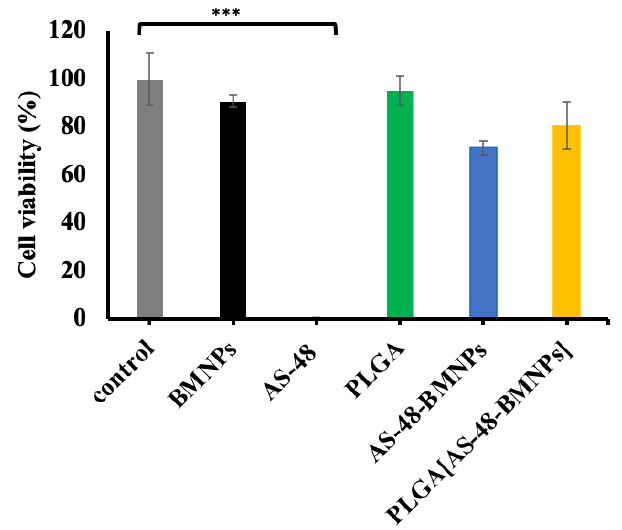
Figure 8. Viability assay in TH1-P cell line following treatment with culture medium (control), BMNPs (229 μg/mL), AS-48 (32 μg/mL), PLGA (457 μg/mL), AS-48-BMNPs (229 μg/mL BMNPs and 32 μg/mL AS-48), PLGA[AS-48-BMNPs] (457 μg/mL PLGA, 229 μg/mL BMNPs and 32 μg/mL AS-48). *** p ≤ 0.0001 when compared to control value s.